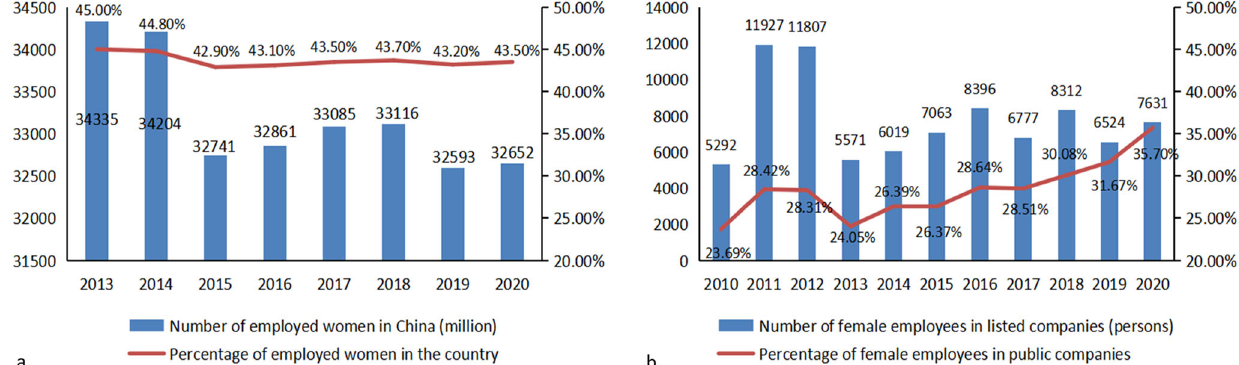
Fig. 2 Female employment situation in Chinese society and in the listed companies. a Female employment in China as a whole. b Female employment in the listed